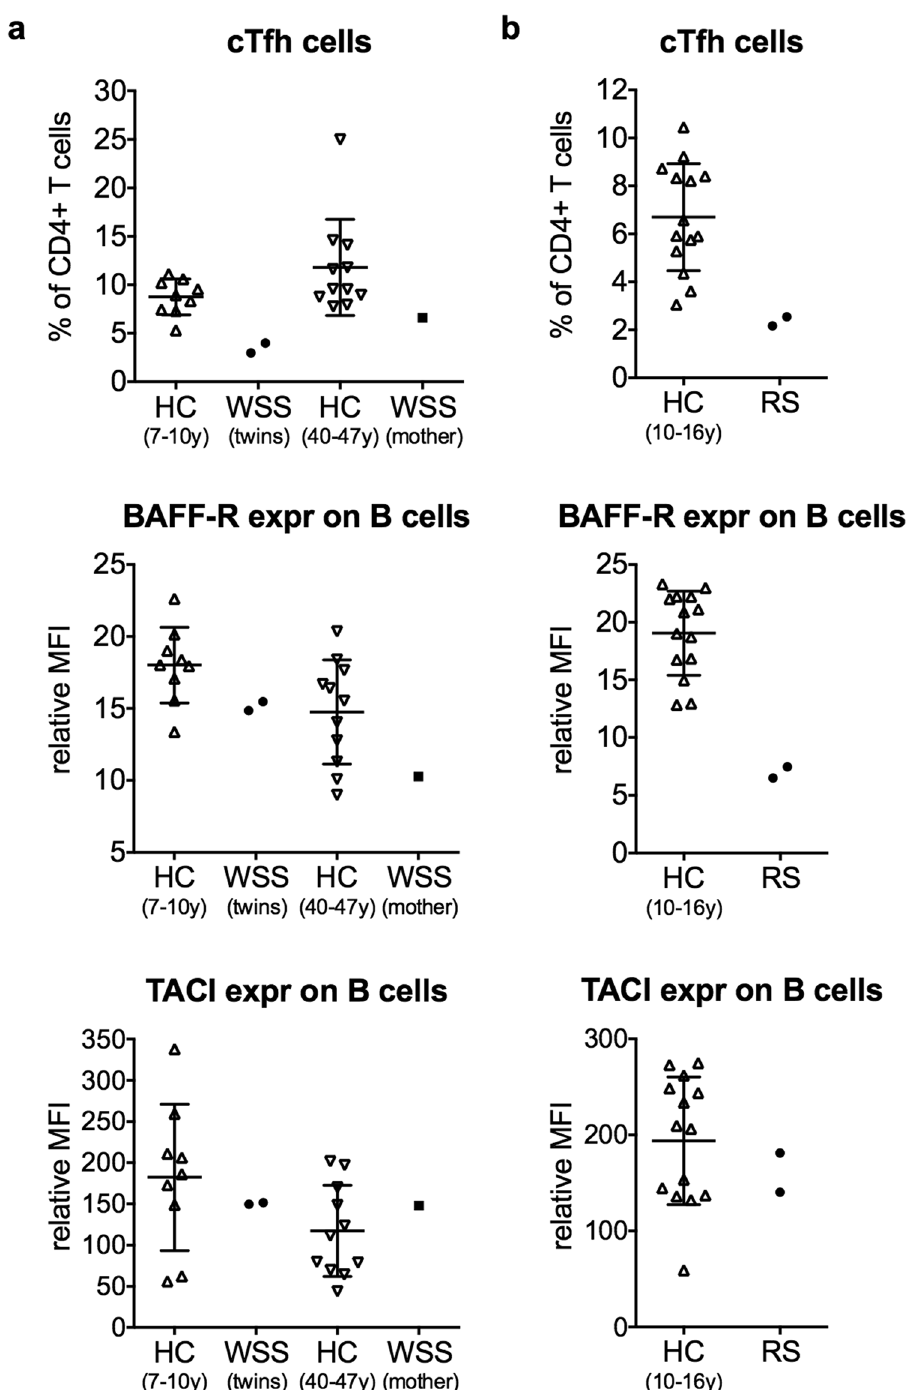
Figure 3. cTfh cells, BAFF-R expression and TACI expression in WSS and RS patients. ( a ) Family A patients with KMT2A -associated Wiedemann-Steiner syndrome (WSS). The twins (II:2, II:3) were 8 years old and the mother (I:2) was 43 years old at time of analysis. ( b ) Family B patients with RNU4ATAC -associated Roifman syndrome (RS). At time of analysis, the patients (II:1, II:2) were 14 and 11 years old, respectively. Flow cytometric immunophenotyping was performed on patients’ PBMCs in comparison with age-matched healthy controls (HC). T cells were gated as CD3 + and B cells as CD19 + CD20 + in total PBMCs. Circulating follicular helper T (cTfh) cells were gated as CXCR5 + CD45RO + in CD4 + T cells. BAFF-R and TACI expression were measured on B cells. Relative mean fluorescence intensity (MFI) was calculated by dividing the MFI of the positive population by the MFI of the Fluorescence Minus One (FMO) population. Graphs of the HC groups represent mean ± standard deviation. BAFF-R: B cell activating factor-receptor, cTfh: circulating follicular helper T, expr: expression, TACI: transmembrane activator and calcium modulator and cyclophilin ligand